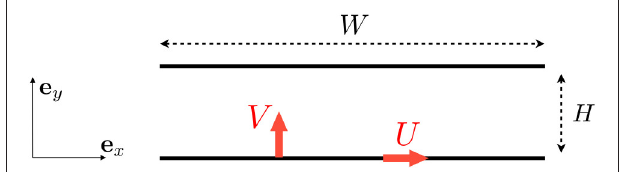
FIGURE 2 | Setup for the flow induced between the tongue and the palate. We denote by U the longitudinal velocity of the tongue (leading a shear flow) and V its vertical upward velocity (leading to a squeeze, pressure-driven